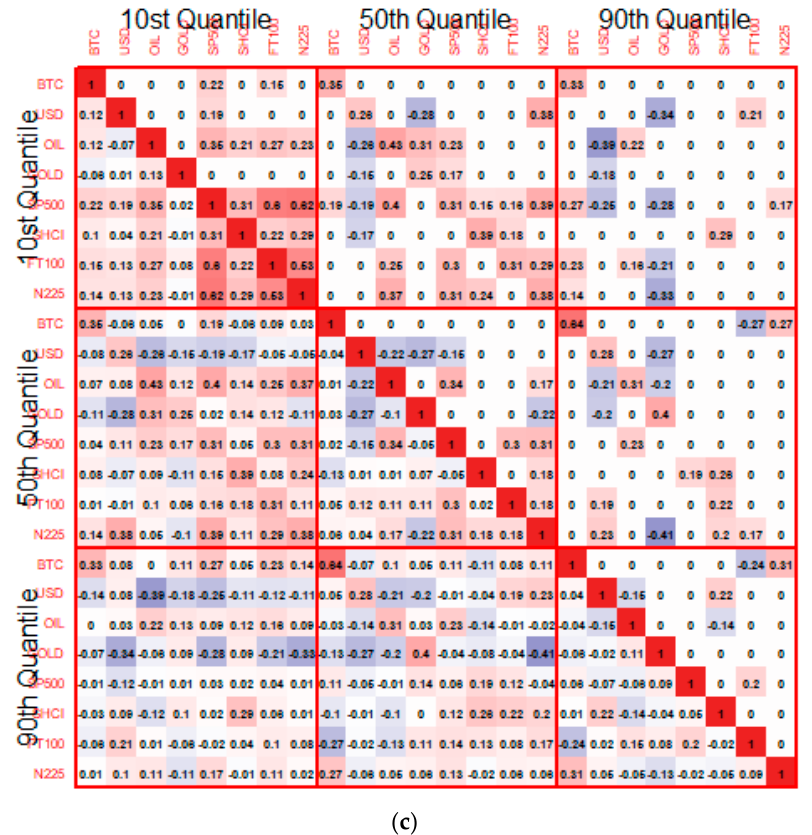
Figure 3. Quantile coherency (QC) matrices (quantile at 1%, 5% 50%). Note: Above the diagonal, non − significant values at 5% significance level are set to zero. Red and blue grids denote positive and negative values, respectively: ( a ) Short − term QC matrix; ( b ) Medium − term QC matrix; ( c ) Long − term QC matrix.